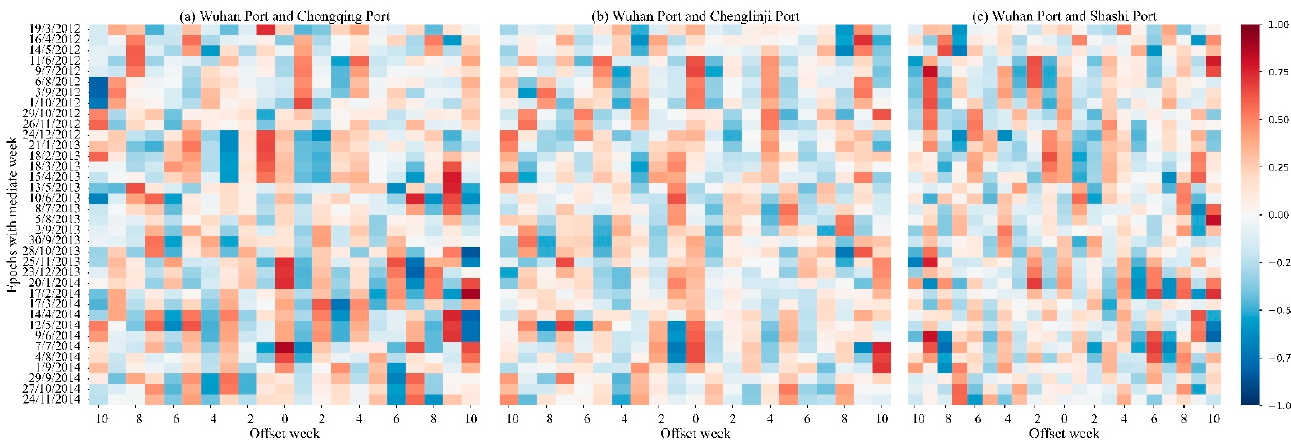
Figure 7. Rolling windowed time-lagged cross-correlation between Wuhan Port and Chongqing Port, Chenglingji Port, and Shashi Port.